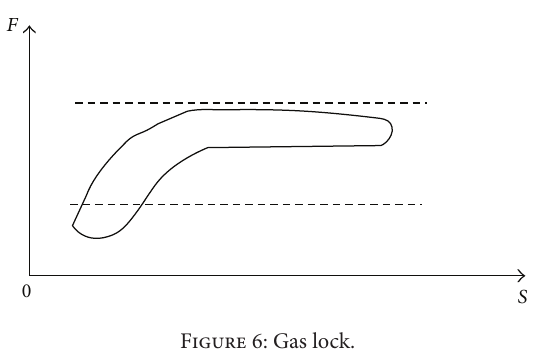
Figure 4: Top Pump bumping.